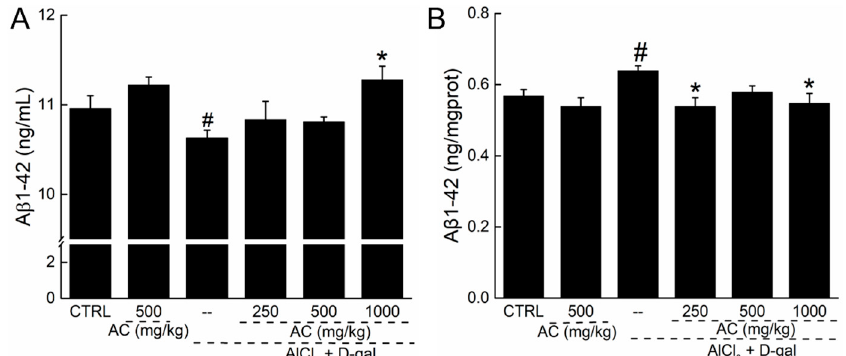
Figure 6. The effect of AC on the levels of A β 1-42 in serum and brain of AD-like mice. 28-day AC administration enhanced the levels of A β 1-42 in serum ( A ); but reduced the levels of A β 1-42 in brain ( B ) of AD-like mice. Data expressed as mean ± S.E.M. ( n = 12). # p < 0.05 vs. control mice, * p < 0.05 vs. AD mice.